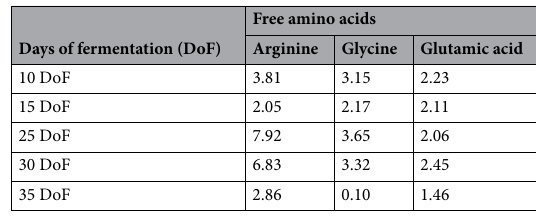
Table 2. Similarity percentage analysis (SIMPER) showing average dissimilarity percentages of most common amino acid in two types of ensilages at the end of different days of fermentation (DoF).